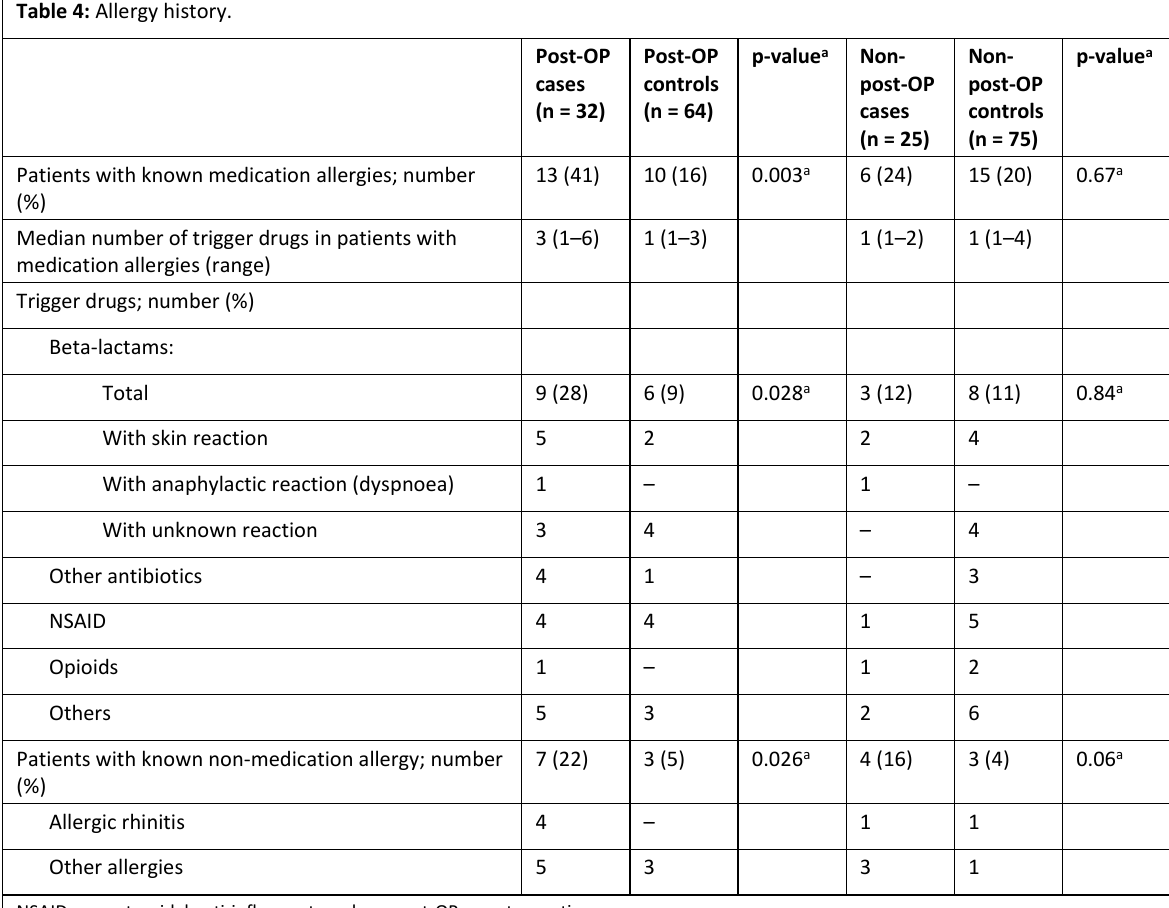
Table 4: Allergy